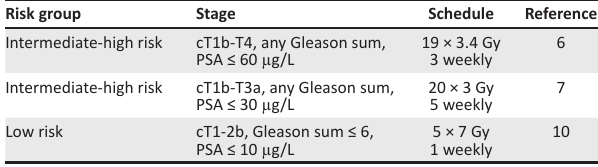
TABLE 1: Hypofractionated